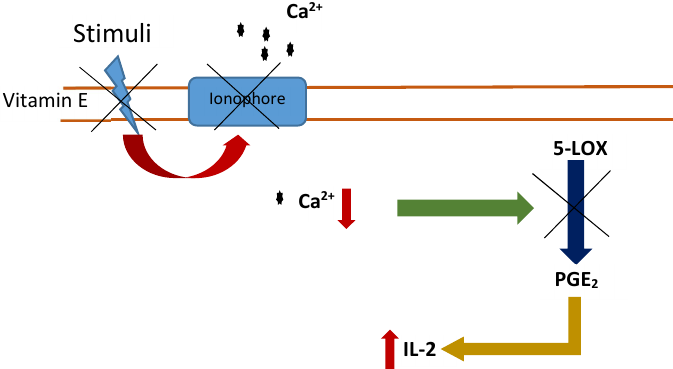
Figure 1. Inhibition of 5-LOX activity by vitamin E. Vitamin E blocks calcium ionophores inducing a reduction in the intracellular calcium levels, triggering the inhibition of 5-LOX activity and inducing the inhibition of the prostaglandins (PGE 2 ). Interleukin 2 (IL-2) levels increase and consequently an immune response.